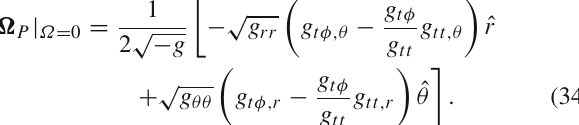
show that the precession frequency is maximum at the